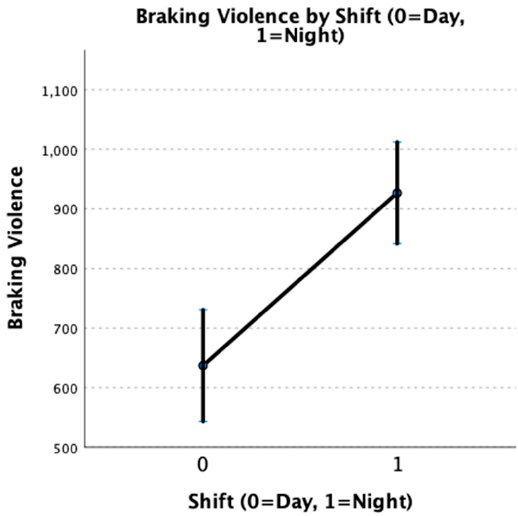
Figure 3. Braking violence by participant work shift.